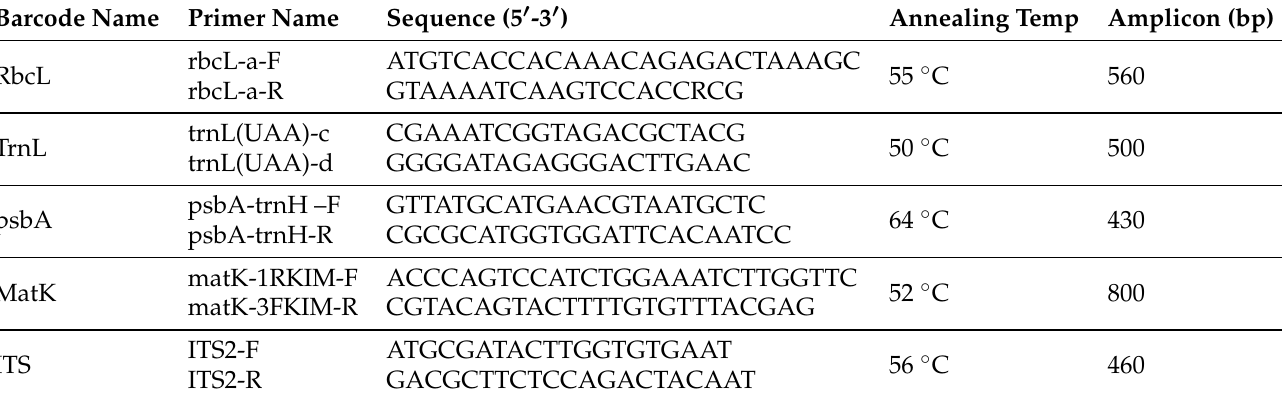
Table 2. List of barcodes with primer sequences, annealing temperatures, and the mean expected amplicon sizes. Barcode